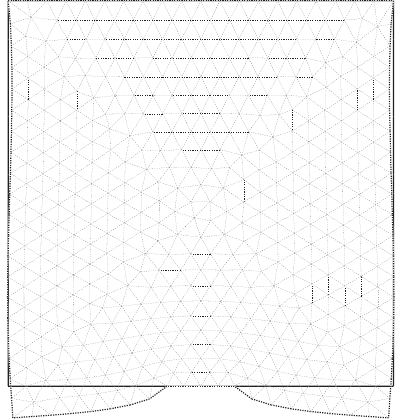
Figure 4.6 . Deformed mesh at final time and initial